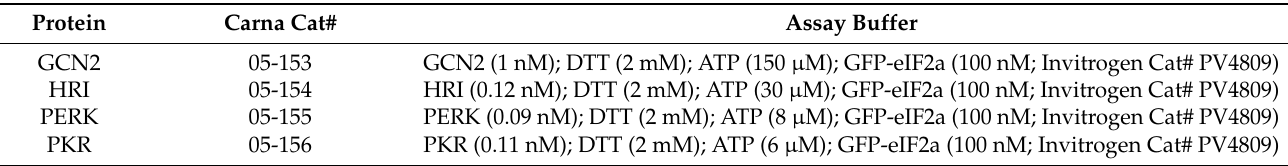
Table 1. Reagents and conditions used in biochemical characterization of ISR